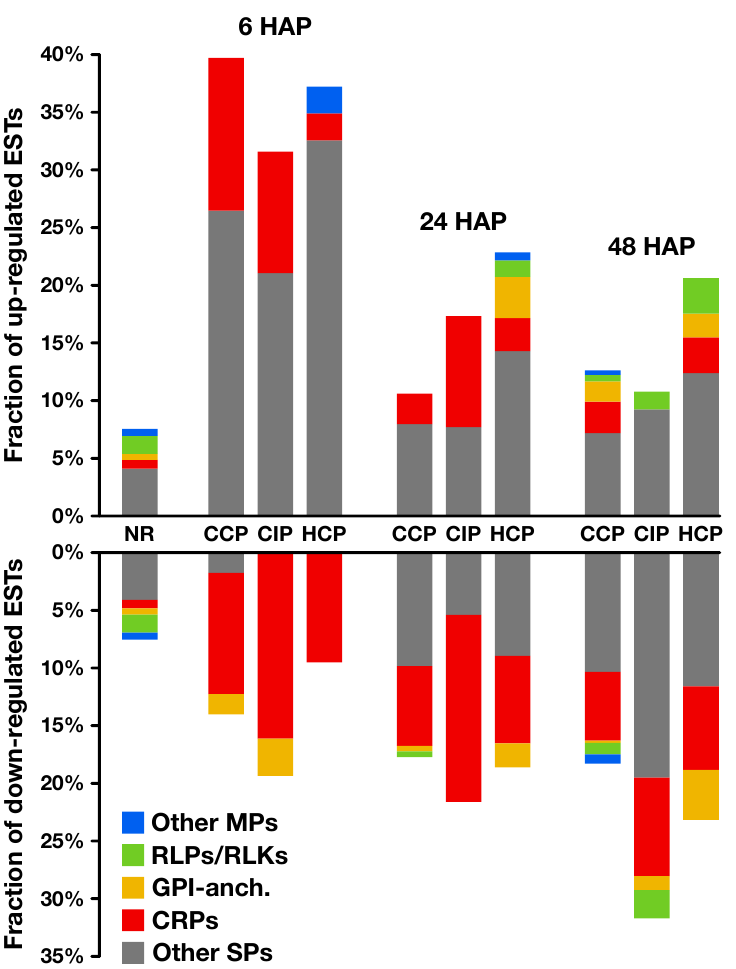
Figure 7. Secretion predictions on regulated genes. For each time point and each pollination condition, proportion of up- ( top ) and down-regulated ( bottom ) genes predicted to encode proteins possessing a secretory signal peptide. Among them, cysteine-rich proteins ( CRPs , red) and other non-membrane secreted proteins ( Other SPs , gray), predicted GPI-anchored proteins ( GPI-anch. , yellow), putative receptor-like proteins and receptor-like kinases ( RLPs/RLKs , green), and other membrane-bound secreted proteins ( Other MPs , blue). Corresponding data on non-regulated ( NR ) transcripts is shown as a